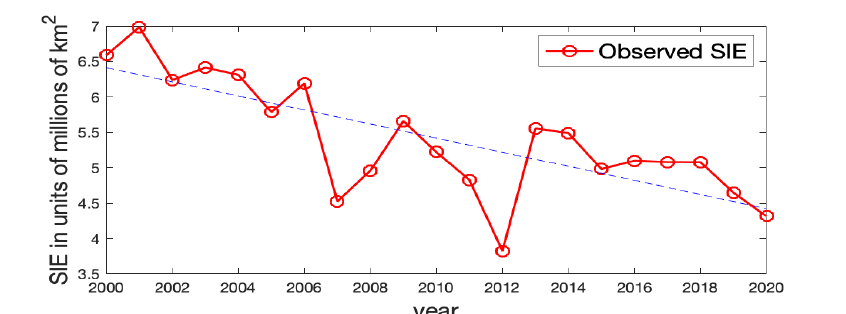
Figure 1. The observed Arctic SIE from 2000 to 2020, with a fitted linear regression line (blue dashed line) using year t as a single